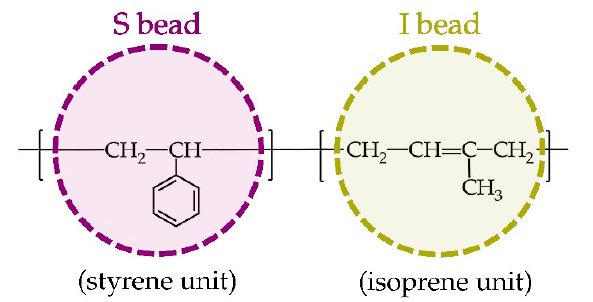
Figure 1. Chemical structures of styrene and isoprene units and their corresponding coarse-grained beads in the simulation system.